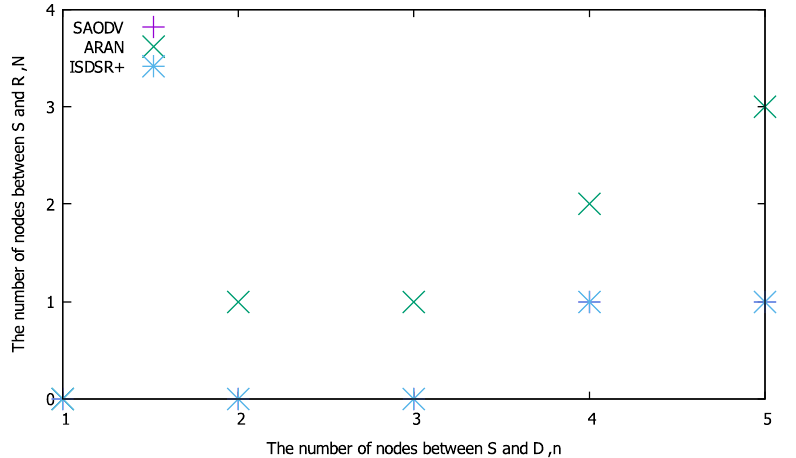
Figure 8. Threshold of N for n at which the proposed method is superior to the compared methods in terms of the routing overhead.